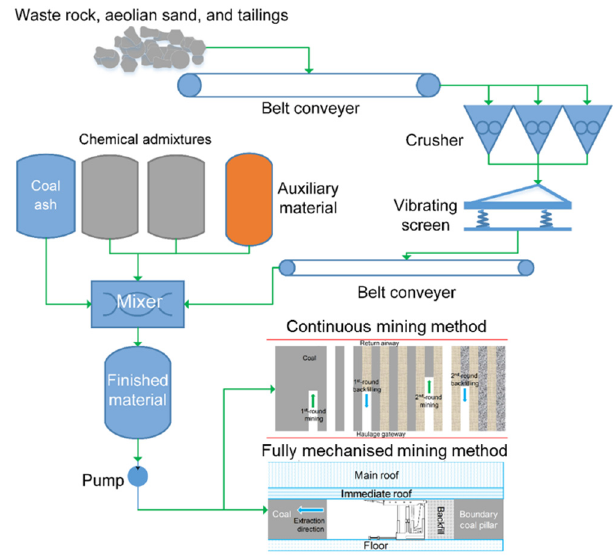
Figure 4. Diagram of underground paste backfilling (drawing designed by Xiaowei